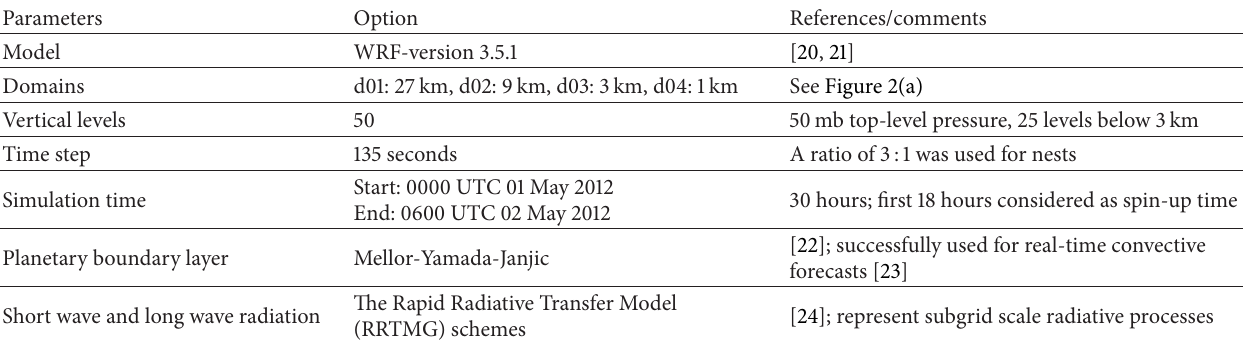
Table 1: Model options used in this